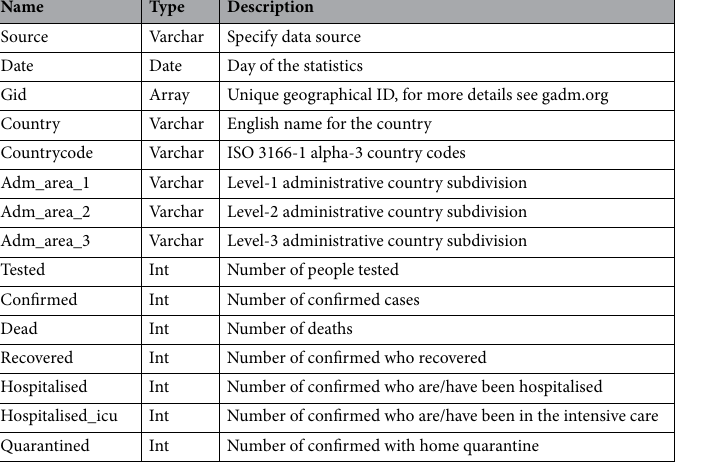
Table 2. Schema for EPIDEMIOLOGY